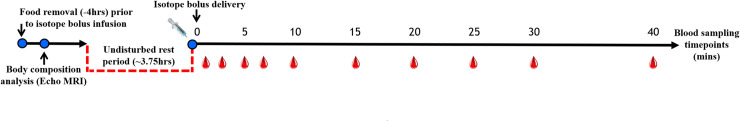
Study timeline.Study timeline depicts procedures performed prior to and following isotope bolus delivery (min 0). Blood sampling times are depicted by blood drop images at minutes 1, 3, 5, 7, 10, 15, 20, 30, & 40.